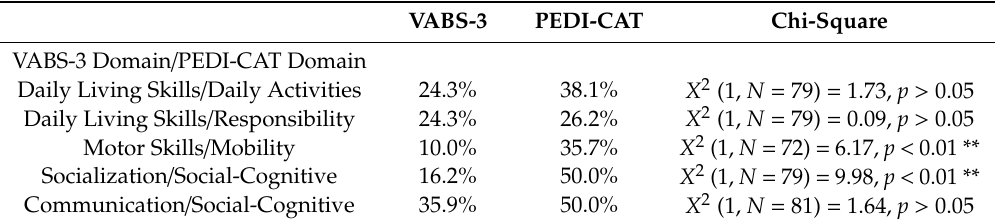
Table 4. Percentage of participants earning lowest score (floor e ff ect) on comparable domains of the VABS-3 and PEDI-CAT at time